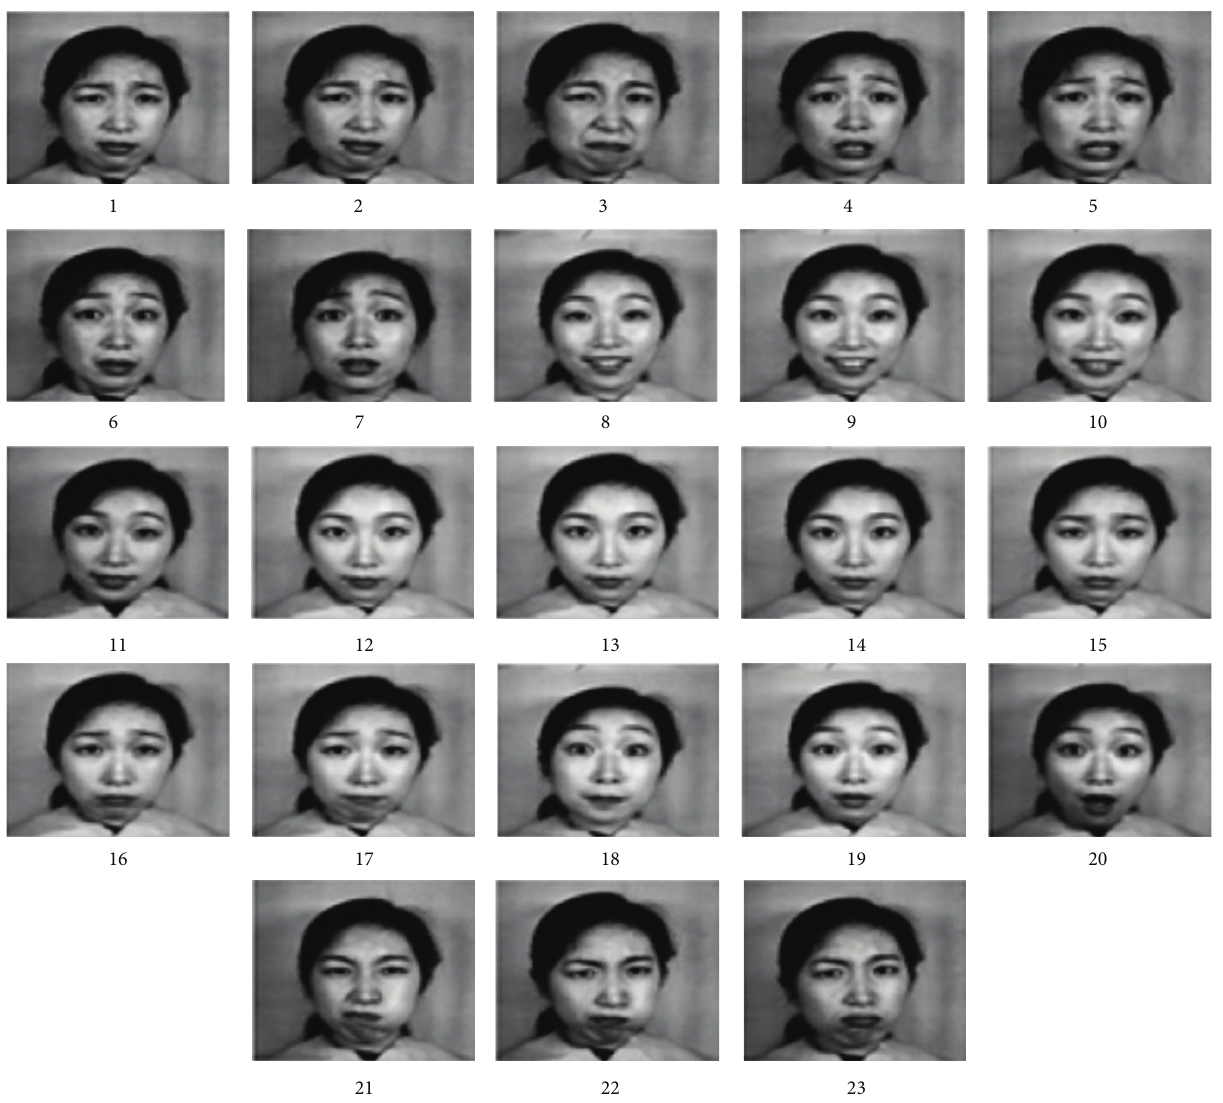
Figure 6: Variations of image 1 of stored database (test database includes total 213 variations of all 10 subjects of stored database, which are compared with only 10 stored database